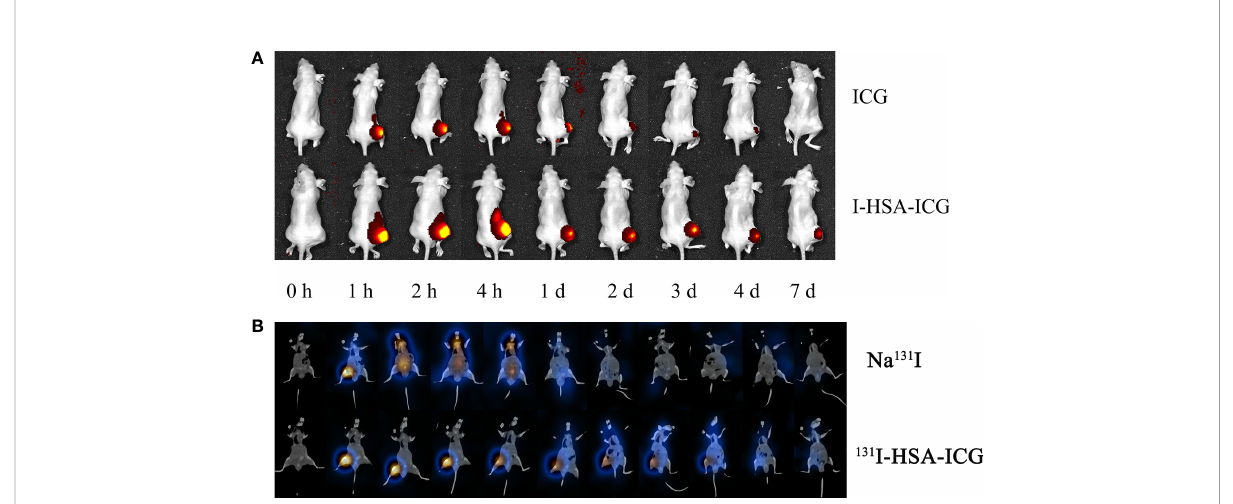
FIGURE 4 (A) In vivo fl uorescence imaging of pure ICG and I-HSA-ICG at different time points. (B) SPECT/CT tomographic images of Na 131 I and 131 I-HSA- ICG at different time points. ICG, indocyanine green; HSA, human serum albumin; SPECT, single-photon emission CT.